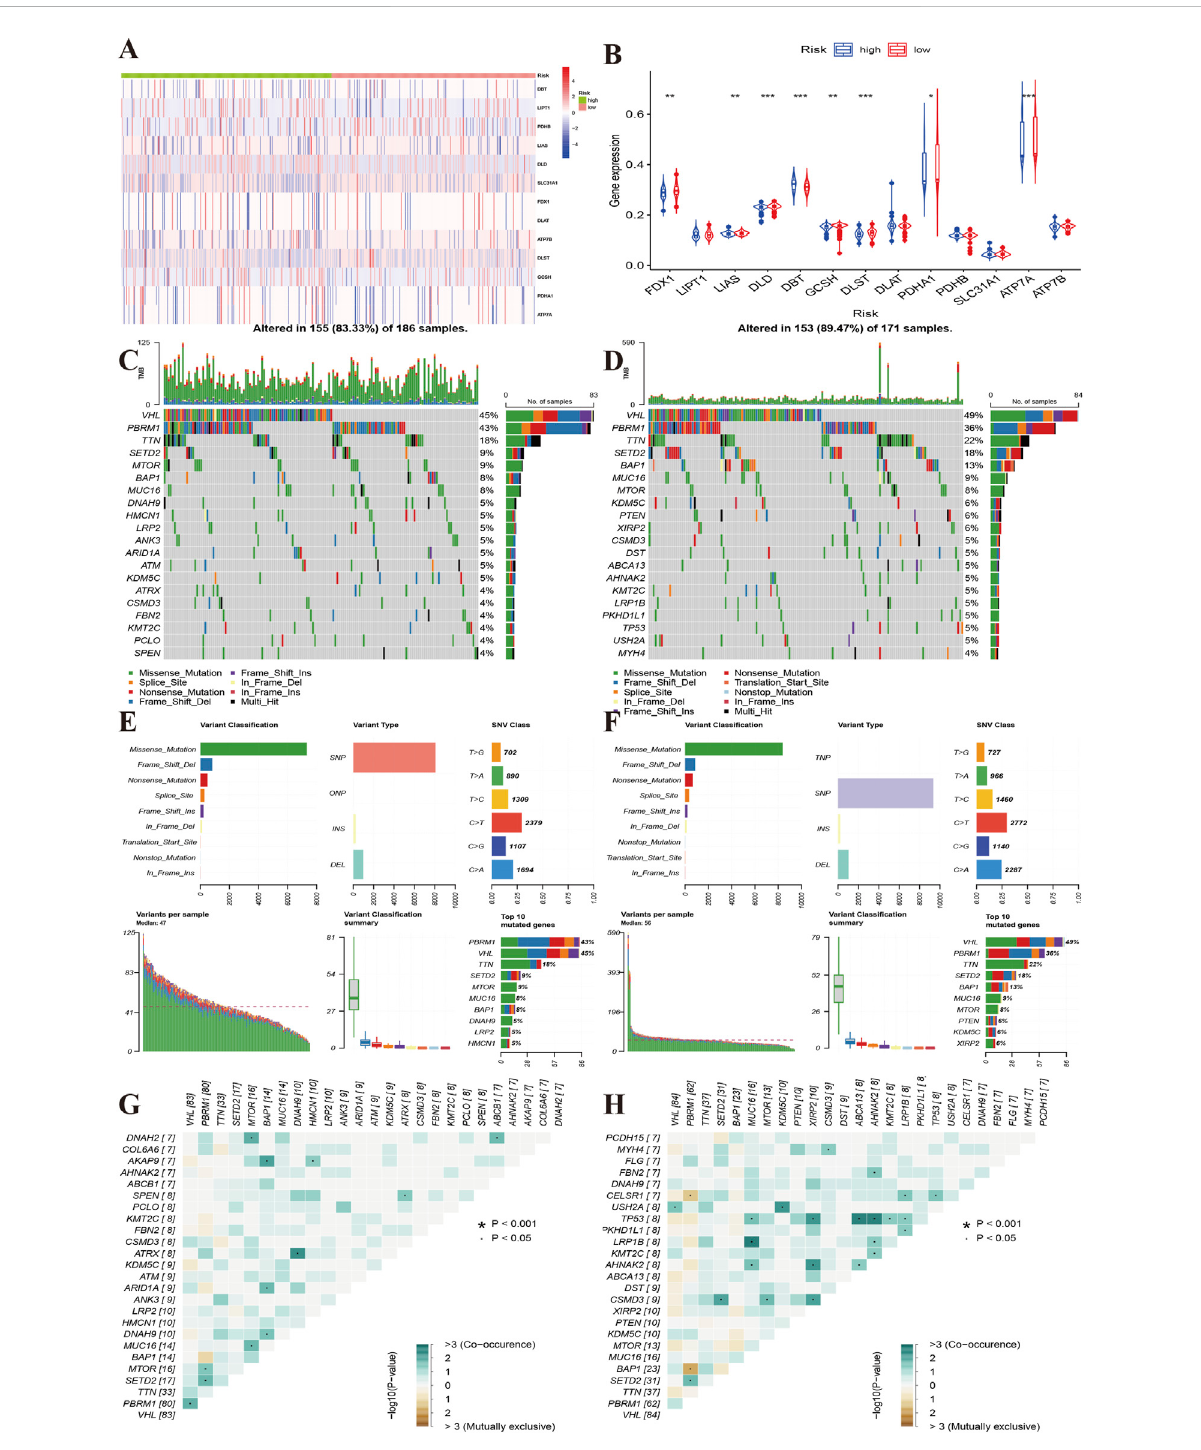
Characteristicsofgenemutationsofdifferentriskgroups. (A) :Heatmapshowingthealterationsofthecuproptosisregulatorgenesbetweenthe highandlow-riskgroups. (B) :Theyellowlineindicatesthelevelofmethylationofthecuproptosisregulatorsbetweenthehigh-andlow-riskgroups. (C,D) : Top 20 gene alterations of the high and low risk groups. (E,F) : Types of gene alterations in the high- and low-risk groups. (G,H) : Summary of gene co-occurrences and mutually exclusive genes of the two risk